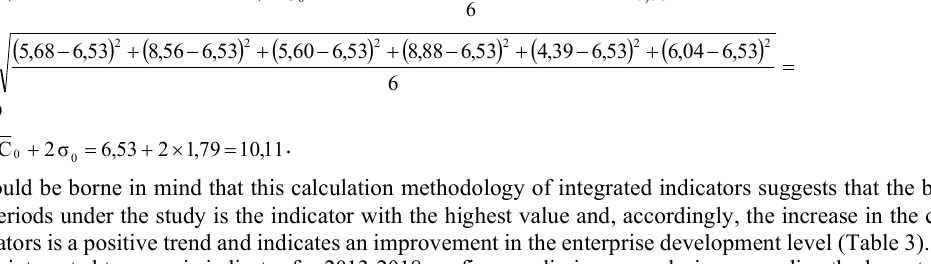
in the development of the enterprise fixed base